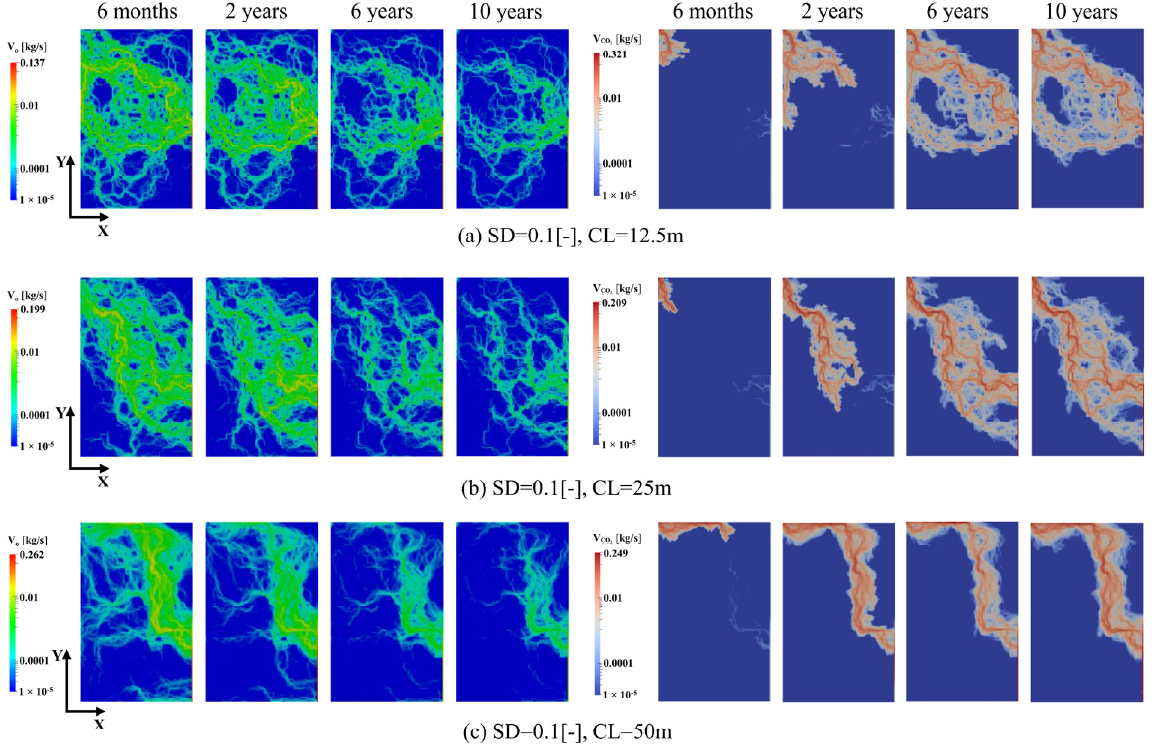
Figure 14. Evolutions of oil and CO 2 flow fields of Set 3. ( a ) SD = 0.1 (-), CL = 12.5 m; ( b ) SD = 0.1 (-), CL = 25 m; ( c ) SD = 0.1 (-), CL = 50 m.